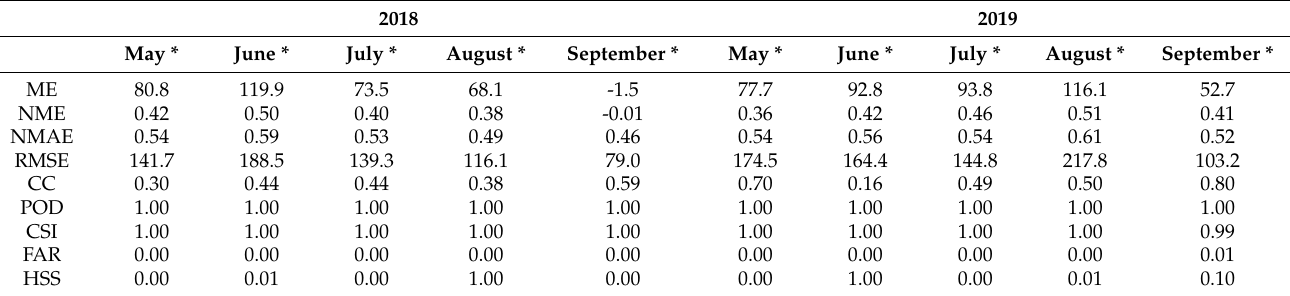
Table 3. Evaluation results of monthly rainfall accumulations (CONUS ‐ west * ). 2018